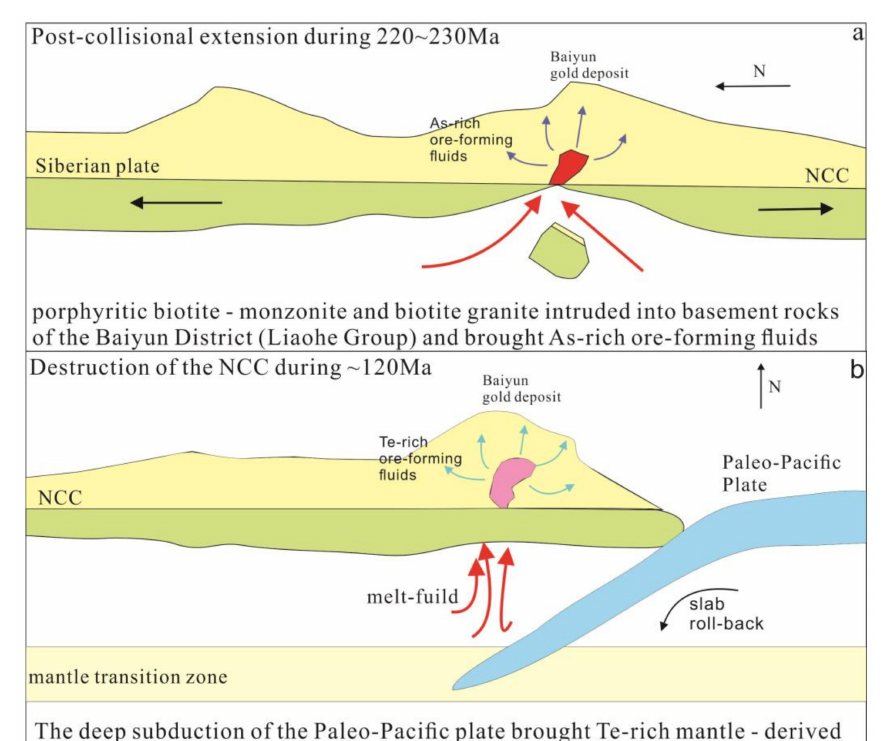
Figure 14. Schematic ore-genetic model for the Baiyun gold deposit. ( a ) Post-collisional extension during 220–230 Ma. ( b ) Destruction of the NCC during ~120